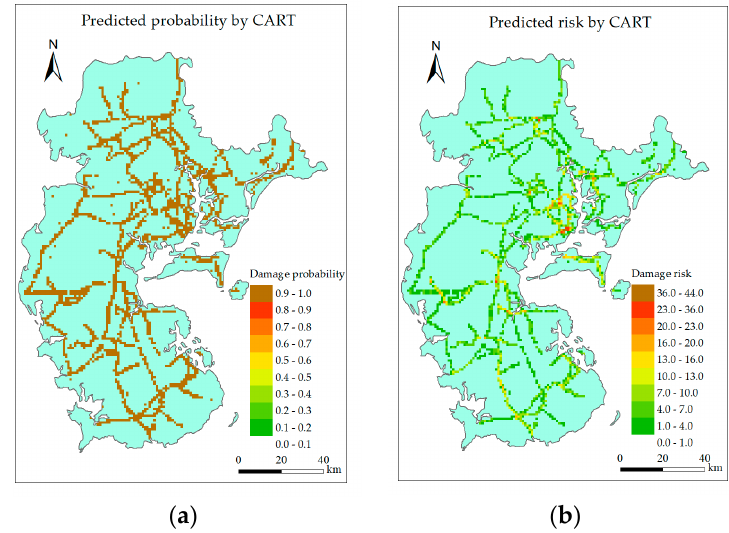
Figure 12. Prediction results of CART. ( a ) Predicted damage probability. ( b ) Predicted damage risk.